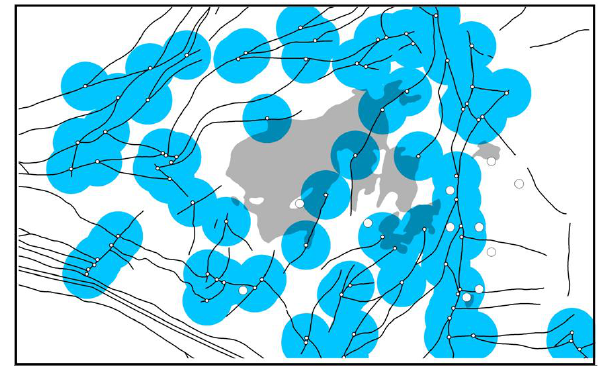
Fig. 5 Faults systems. Black lines represent faults. Blue circles stand for 6km buffer zones around intersections of three fault systems.